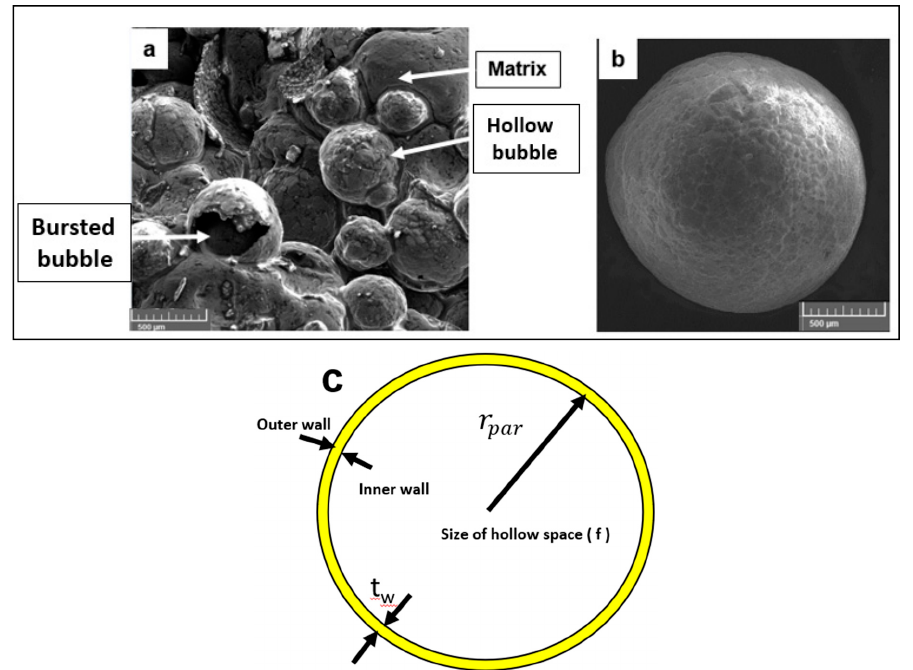
Figure 1. ( a ) A representative AZ31-Mg hollow alumina syntactic foam ( b , c ) hollow ceramic microballoon.